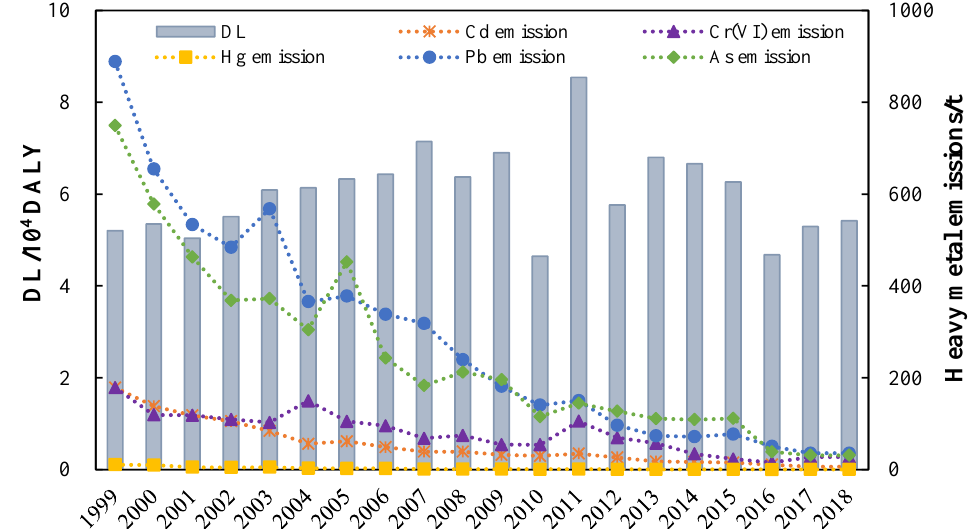
Figure 2. The DL of heavy metal emissions from industrial wastewater in 1999 – 2018.